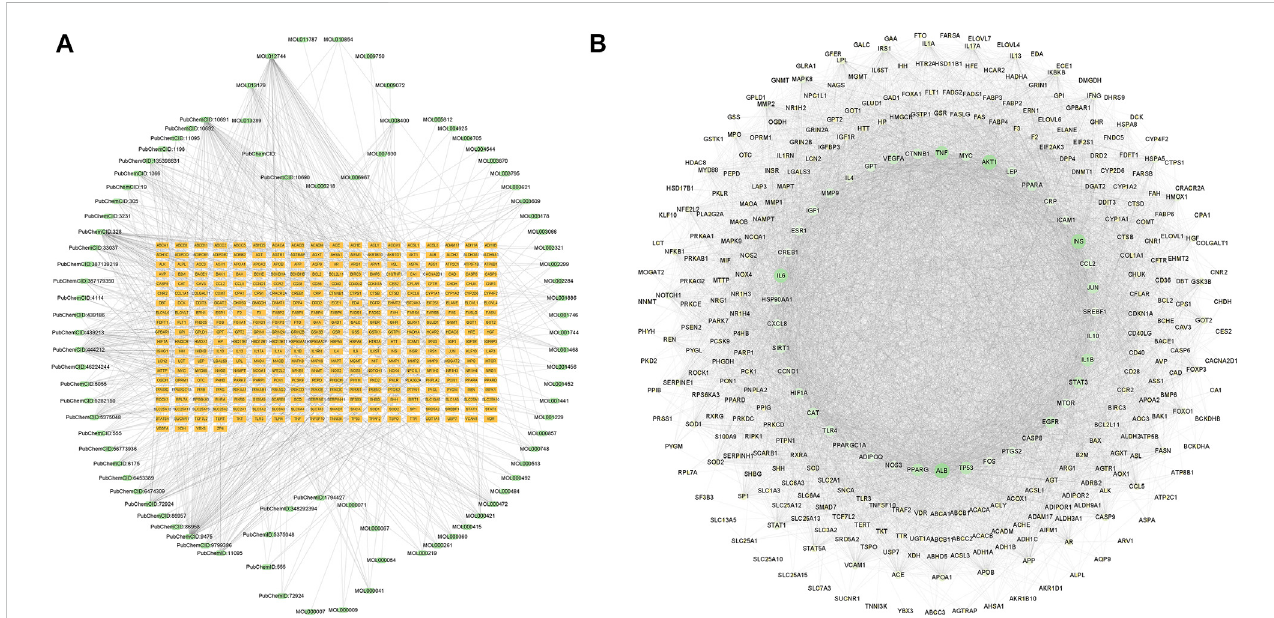
FIGURE 1 Component-target network diagram and protein-protein interaction (PPI) network. (A) Network diagram of GanShuang Granules (GSG) compounds corresponding to targets (orange rectangles represent targets; green dots represent compounds). (B) PPI diagram of the protein interactions between GSG and non-alcoholic fatty liver disease (NAFLD) intersection targets (network nodes represent proteins, line segments represent protein interrelationships; depending on the degree value, the size of the nodes changes from small to large, and the color changes from light to